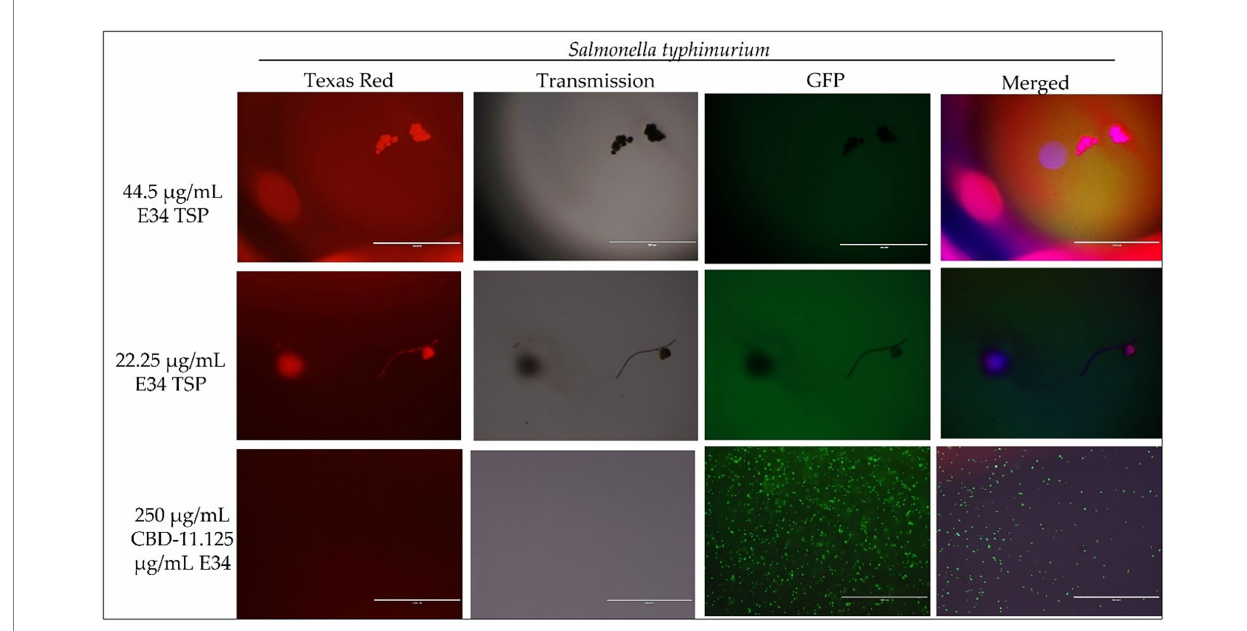
FIGURE 6 Immunofluorescence analysis of S . Typhimurium (ST) at higher concentrations of E34 TSP; 44.5 μ g/ml E34 TSP, 22.25 μ g/ml E34 TSP, and the combination treatment of 250 μ g/ml CBD extract +11.125 μ g/ml E34 TSP. As shown in all panels, treatment at higher concentrations killed the S . Typhimurium. However, bacteria seemed to survive the combination treatment of CBD extract and E34 TSP especially at the higher concentration of 250 μ g/ml CBD